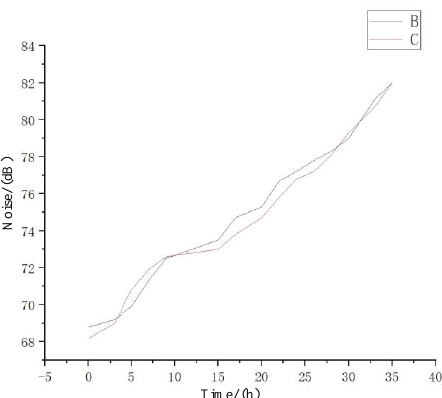
Figure 12. Trend of noise comparison between the gear test bench equipment operation and the state monitoring system simulation.